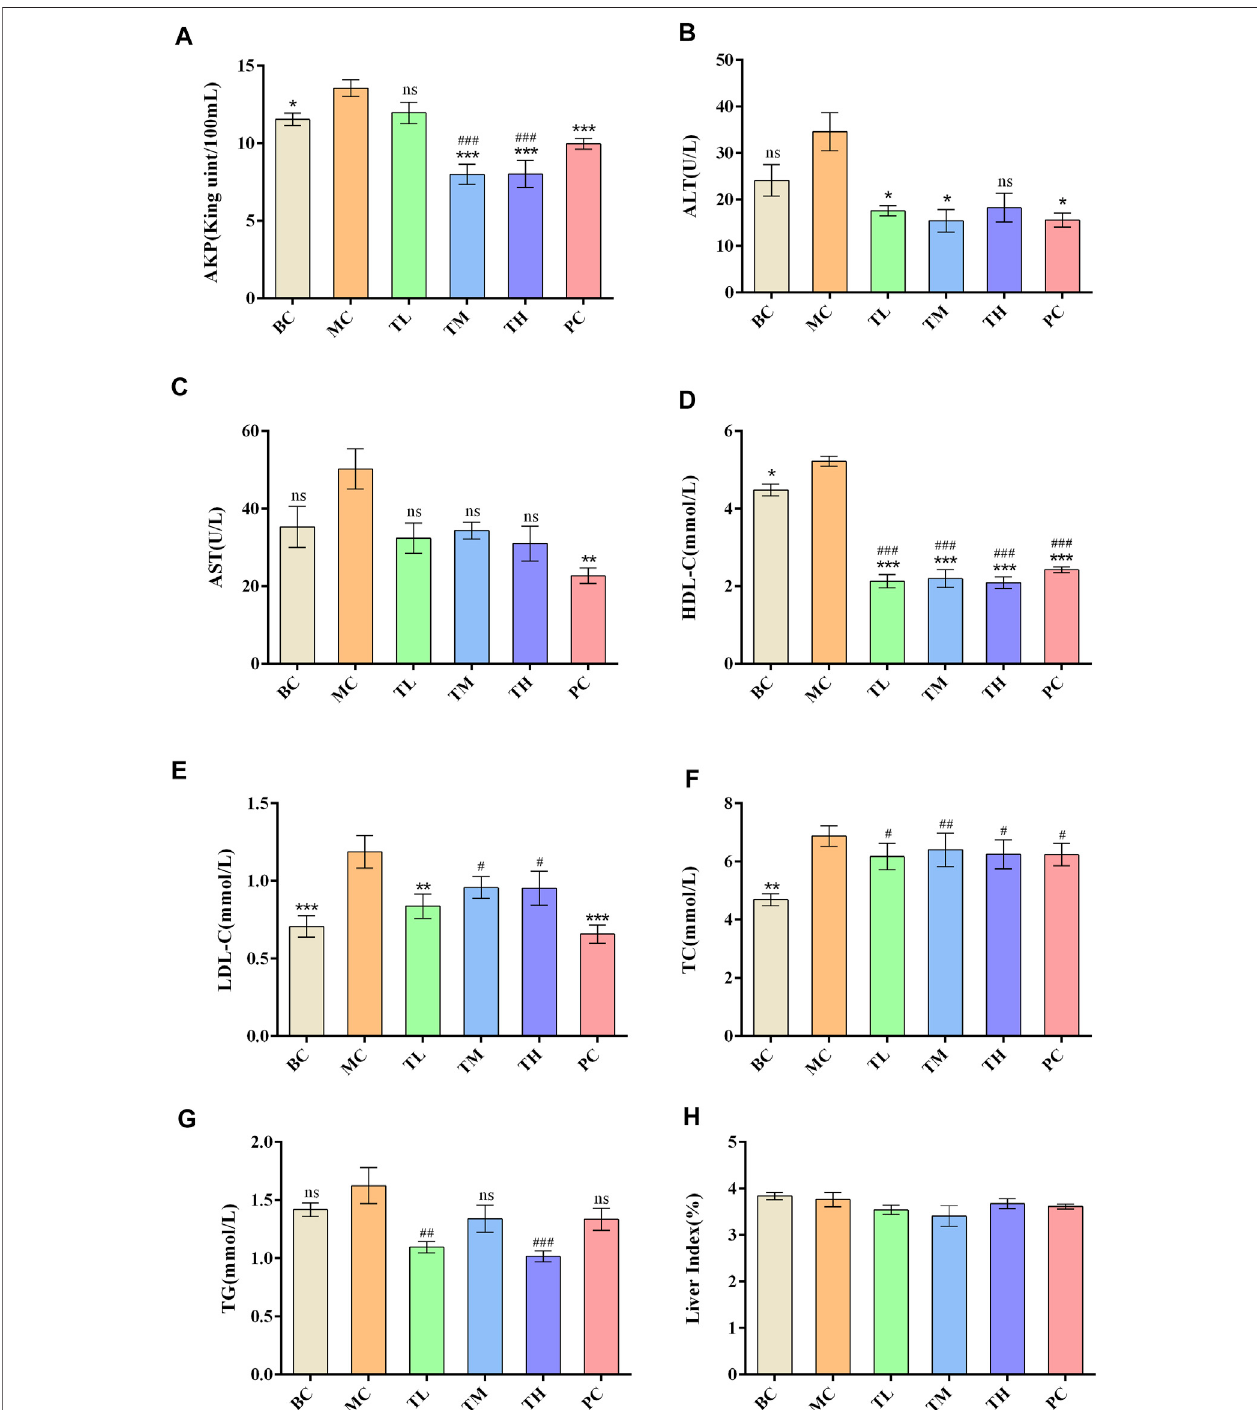
FIGURE 2 | Effect of HRG on biochemical indexes and statistical histogram of organ index in mice. (A) Effects of HRG on serum AKP level in mice. (B) Effects of HRG on serum ALT level in mice. (C) Effects of HRG on serum AST level in mice. (D) Effects of HRG on serum HDL-C level in mice. (E) Effects of HRG on serum LDL-C level in mice. (F) Effects of HRG on serum TC level in mice. (G) Effects of HRG on serum TG level in mice. (H) Effects of HRG on liver index in mice. Compared with the model group, * p < 0.05, ** p < 0.01, *** p < 0.001; compared with the blank group, # p < 0.05, ## p < 0.01, ### p < 0.001).